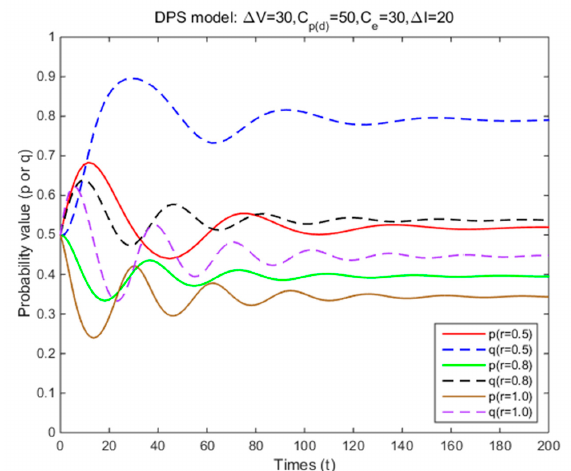
Figure 1. The effects of penalty amount on strategy probabilities of cyclists and law enforcement under FPS ( a ) and DPS ( b ) (Situation 3).